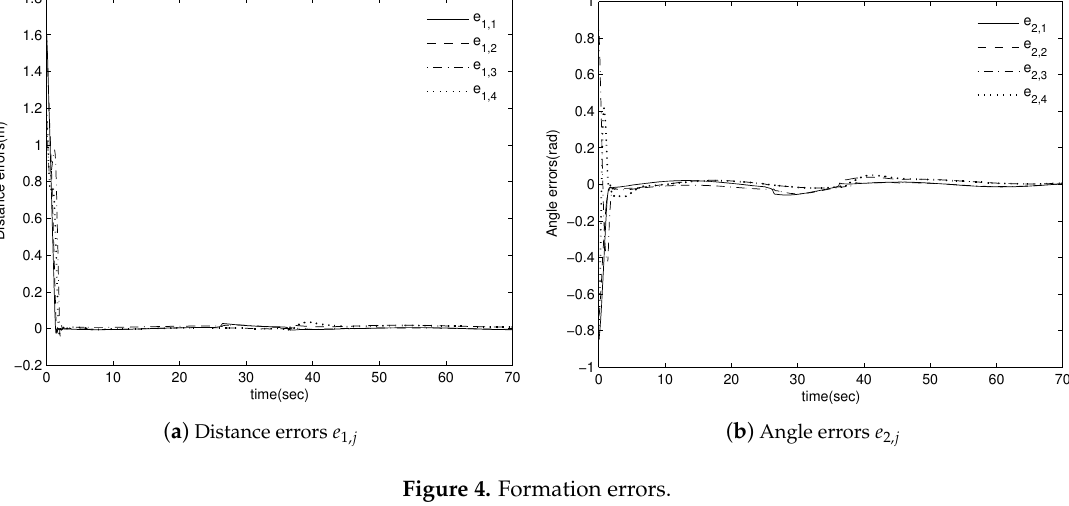
Figure 4. Formation errors.